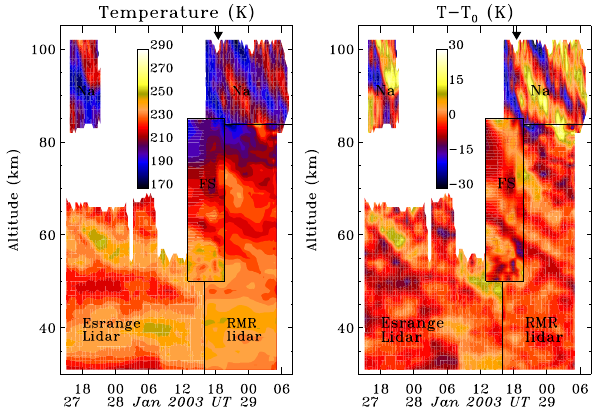
Fig. 16. Waterfall plot for 28 January 2003 of the zonal wind mea- sured from the falling spheres (black), sodium lidar (blue), and me- teor radar (red). The small arrow at the top of each figure represents the launch of NASA 41.031 on 28 January